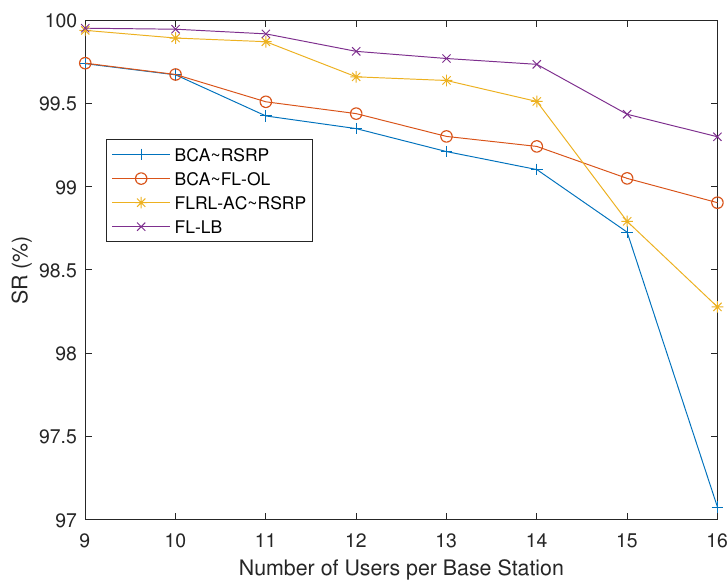
Figure 11. The satisfied ratio with different joint